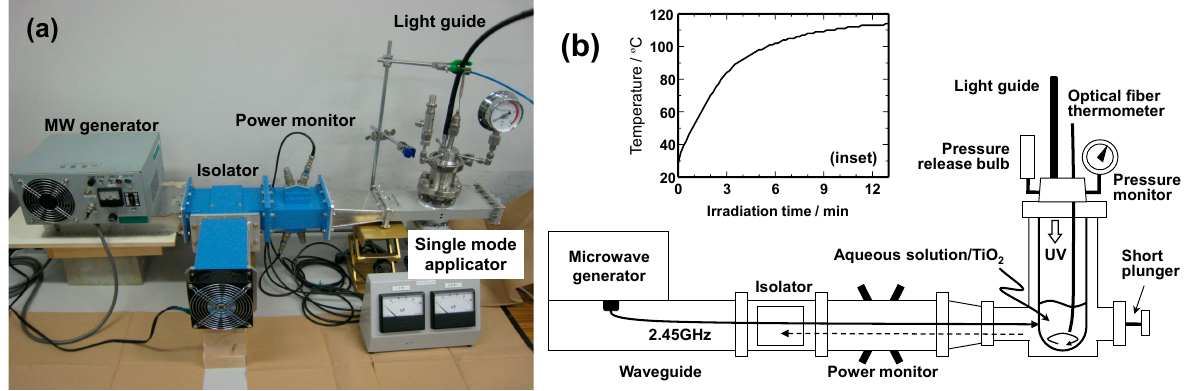
Figure 1. ( a ) Photograph of an integrated microwave/photoreactor system having a single-mode applicator, and ( b ) schematic of the system and a typical plot (inset) of the change of temperature with irradiation time for an aqueous TiO 2 dispersion under microwave